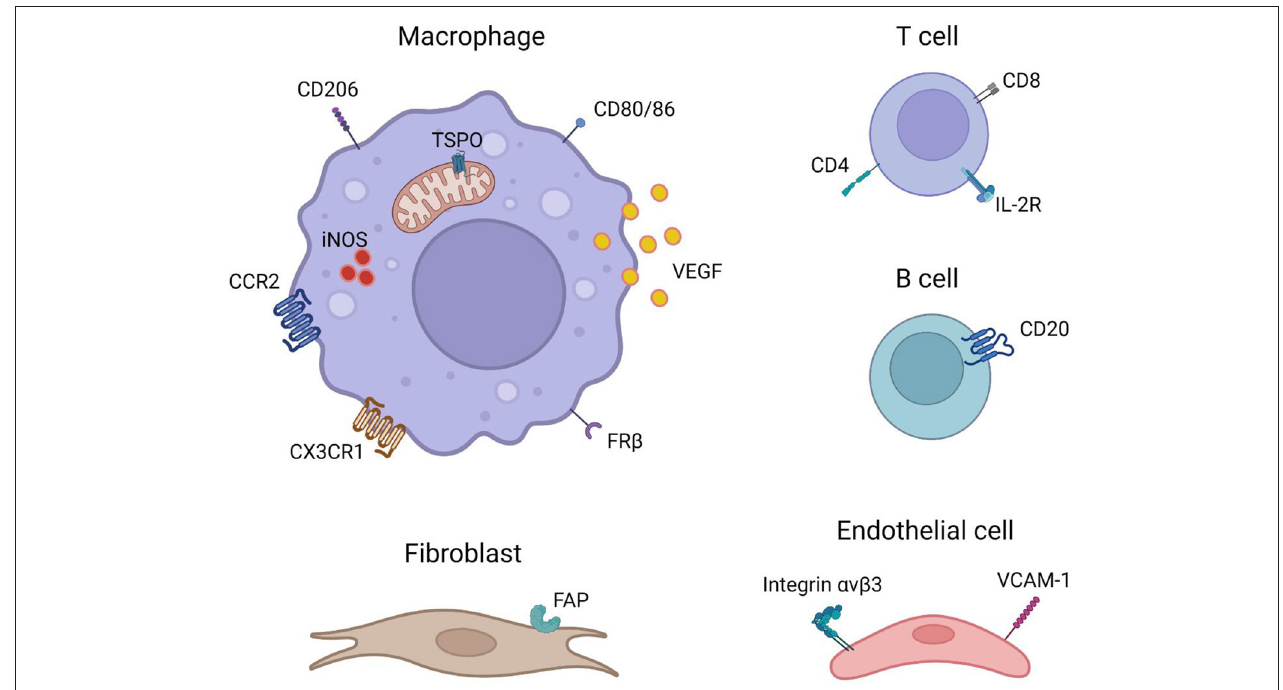
FIGURE 1 | Imaging targets that are potentially useful for the imaging of GCA and PMR (created with BioRender.com).